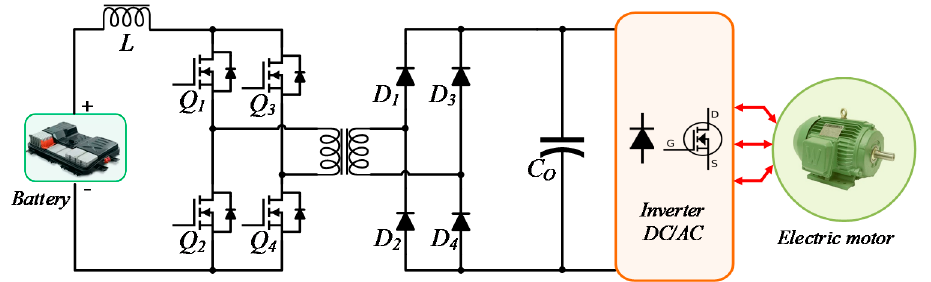
Figure 9 . Full-bridge Boost DC-DC Converter. Figure 9. Full-bridge Boost DC-DC